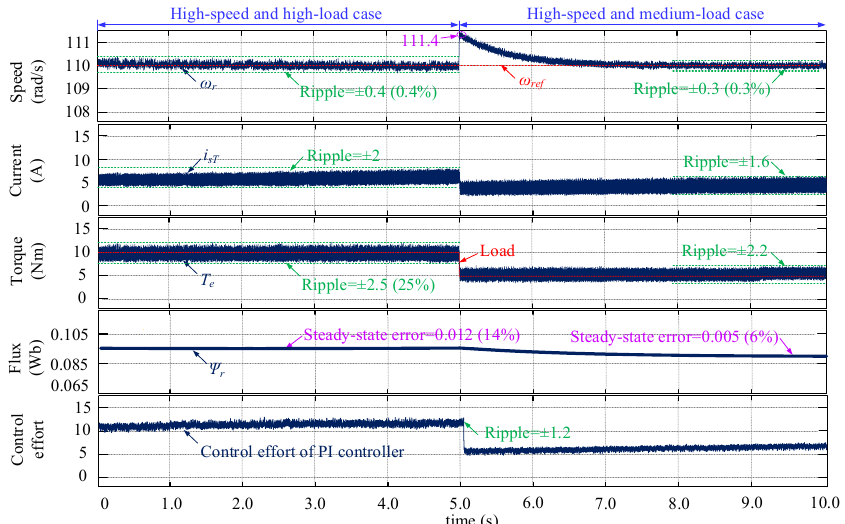
Figure 8. Performance of traditional FCS-MPTC with fixed PI parameters and fixed weighting factor.